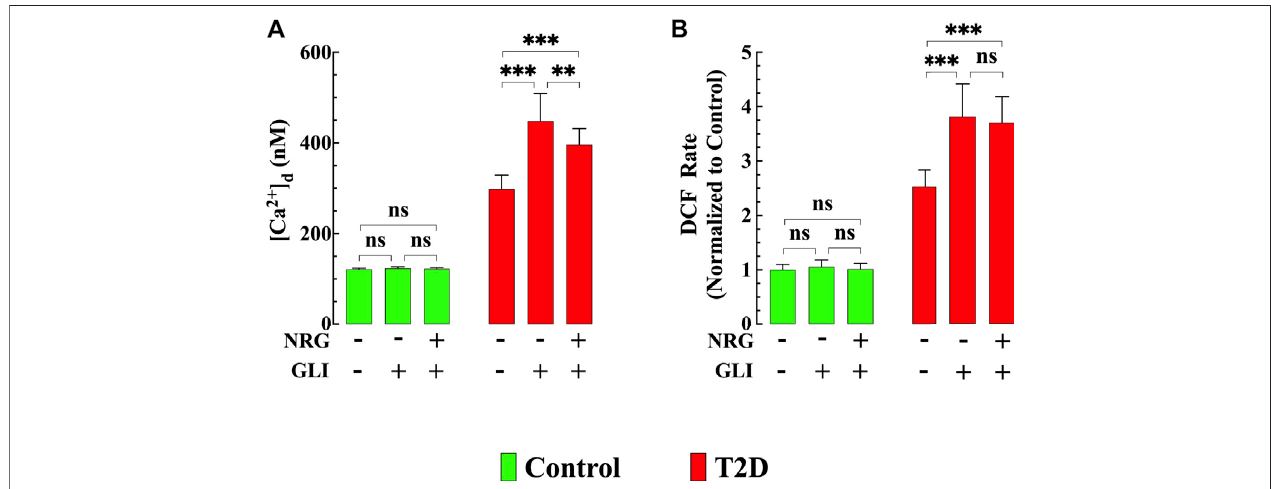
FIGURE7| Glibenclamideworsened diastolic[Ca 2+ ]and ROSdysfunctionand blockednaringincardioprotectioninT2Dcardiomyocytes . InT2Dcardiomyocytes, glibenclamide induced a further signi fi cant elevation of [Ca 2+ ] d ( p < 0.001) and ROS generation ( p < 0.001) compared to untreated T2D cardiomyocytes (A,B) and blockedthecardioprotectiveeffectsofnaringinon[Ca 2+ ] d ,andROSgenerationobservedinT2Dcardiomyocytes (A,B) .Incontrolcardiomyocytesglibenclamidedidnot modify [Ca 2+ ] d ( p (cid:1) 0.06) and DCF rate ( p (cid:1) 0.99). Experimental data were obtained from n mice (cid:1) 5 mice/group ; n cells (cid:1) 15 – 21/group. Values are expressed as means ± S.D. Statistical analysis was performed as described before, ns p > 0.05, ** p < 0.01, *** p < 0.001.